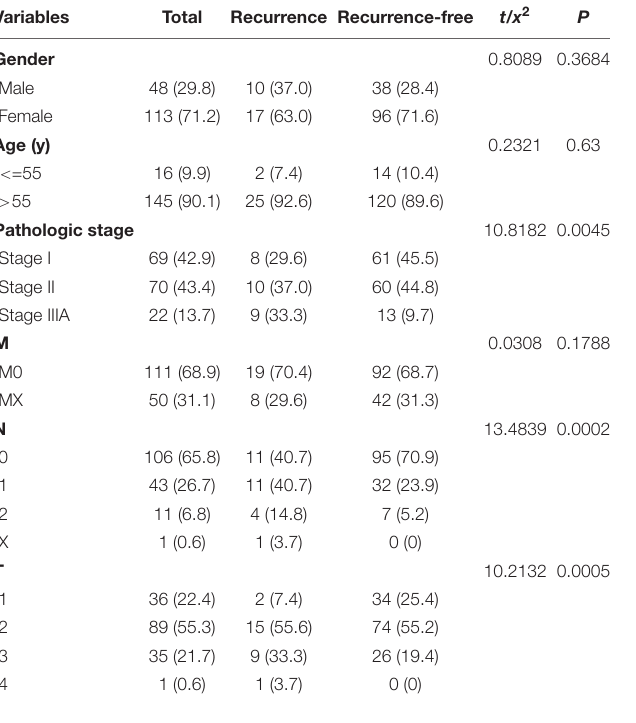
TABLE 1 | Clinical baseline characteristics of 161 patients with recurrence of stage I-IIIA LUSC.